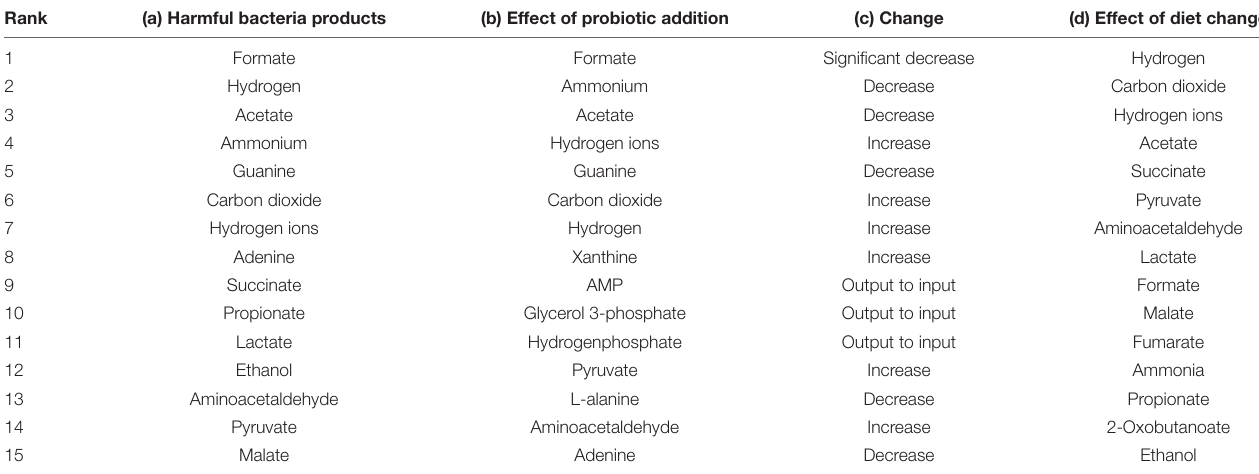
TABLE 3 | Summary of the effect of beneficial bacteria and diet on secretion products of the harmful bacteria.